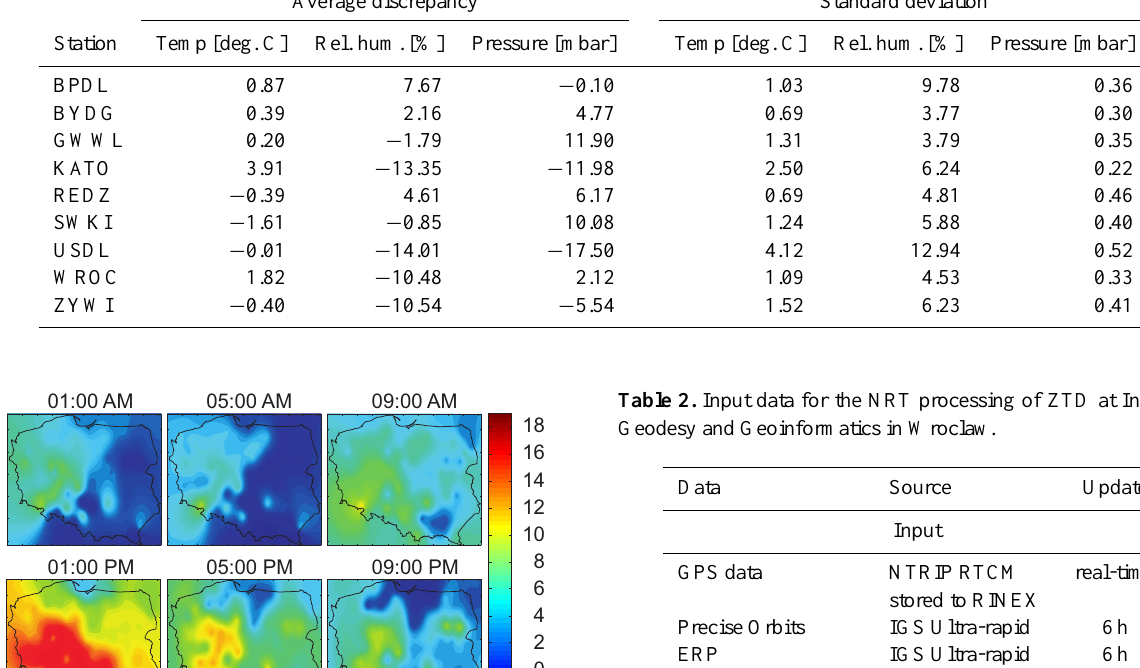
Table 1. Discrepancies of interpolated and real atmospheric parameters on selected ASG-EUPOS stations. Average discrepancy Standard deviation